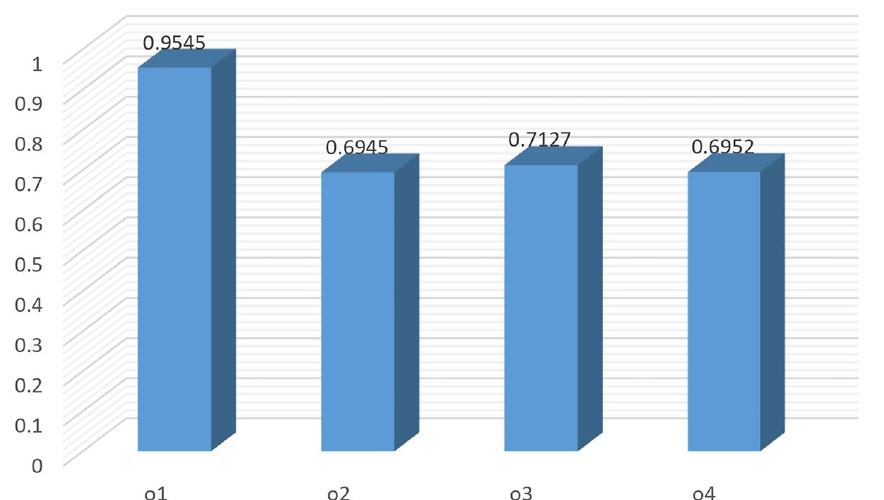
Figure 5. Ranking results when ̟ 1 = 0.343 , ̟ 2 = 0.2 and ̟ 3 = 0.457